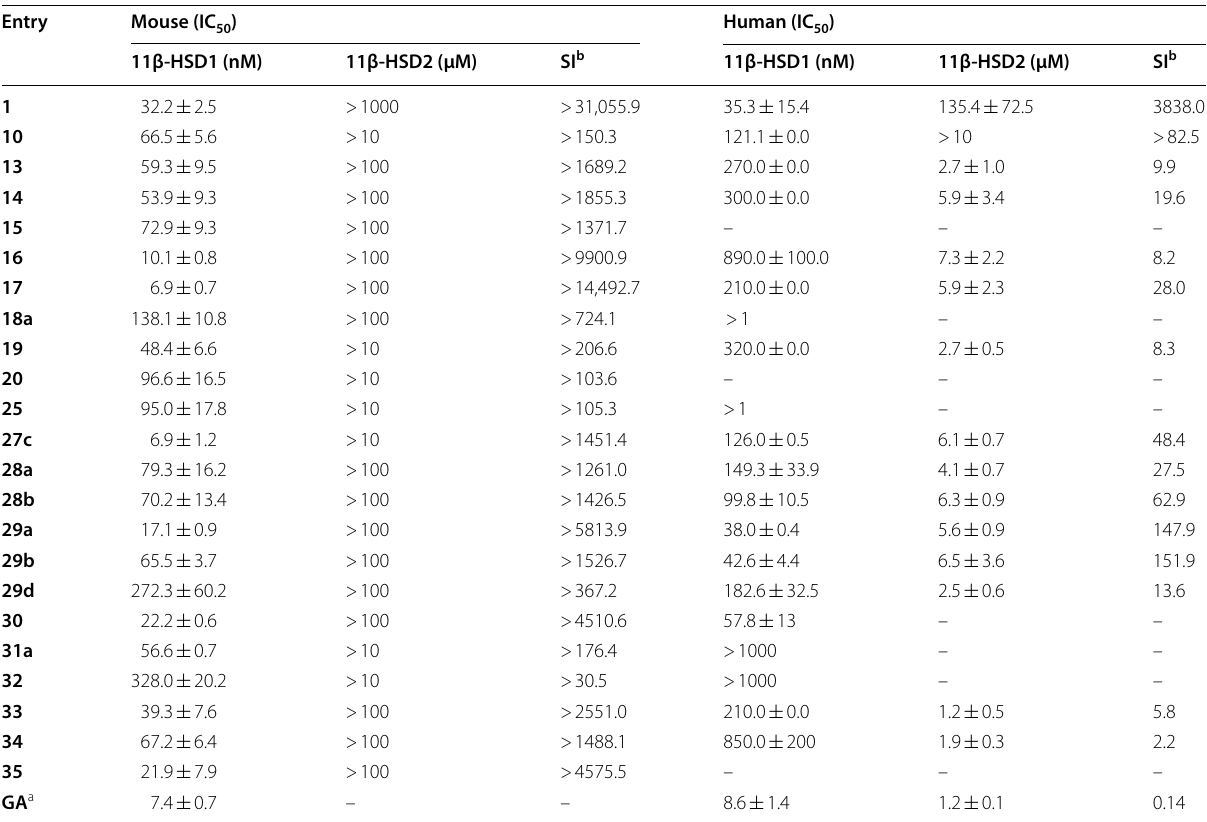
Table 3 IC value and selectivity ratio 50